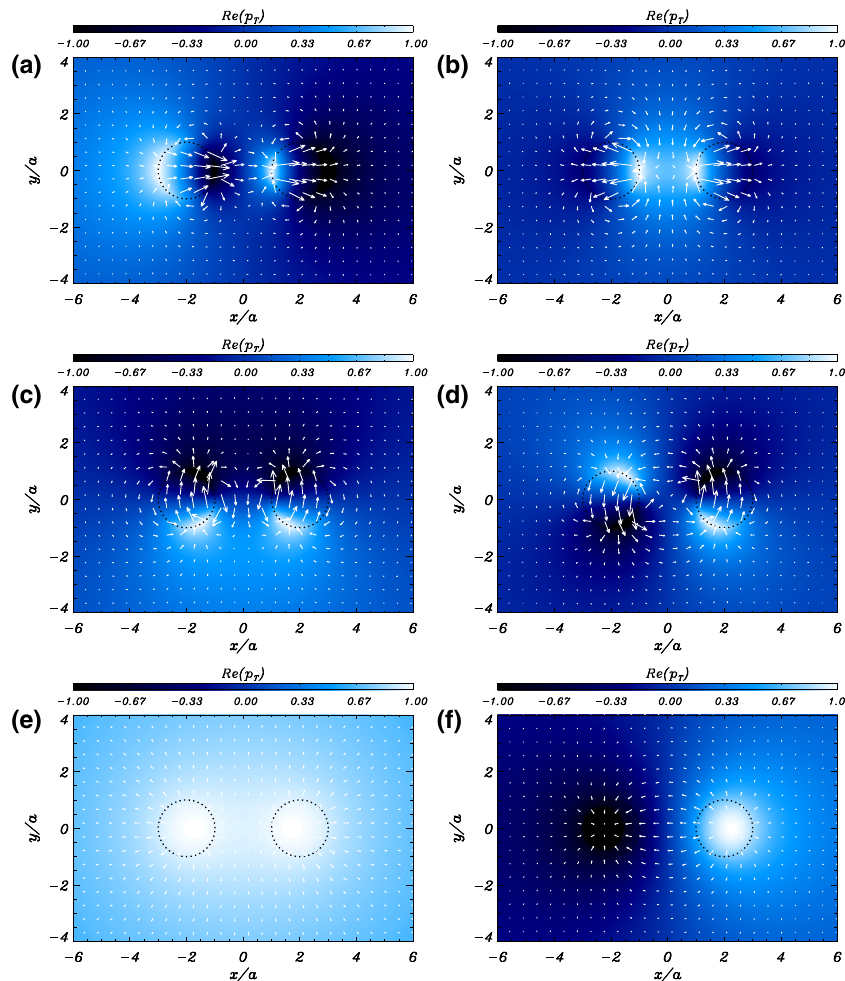
Fig. 47 Fundamental normal modes of two parallel and infinitely long threads (Fig. 46). Total pressure perturbation field (contour plot in arbitrary units) and transverse Lagrangian displacement vector field (arrows) in the xy -plane for the wave modes a S x , b A x , c S y , d A y , e S z and f A z for a separation between threads d = 4 a and a longitudinal wavenumber k z a = 10 − 2 , where a is the thread radius. The prominence thread boundaries are denoted by dotted circles. Image reproduced with permission from